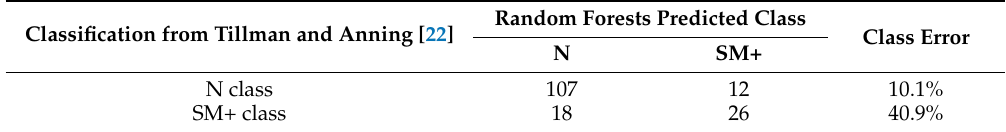
Table 3. Confusion matrix for the predictive random forests